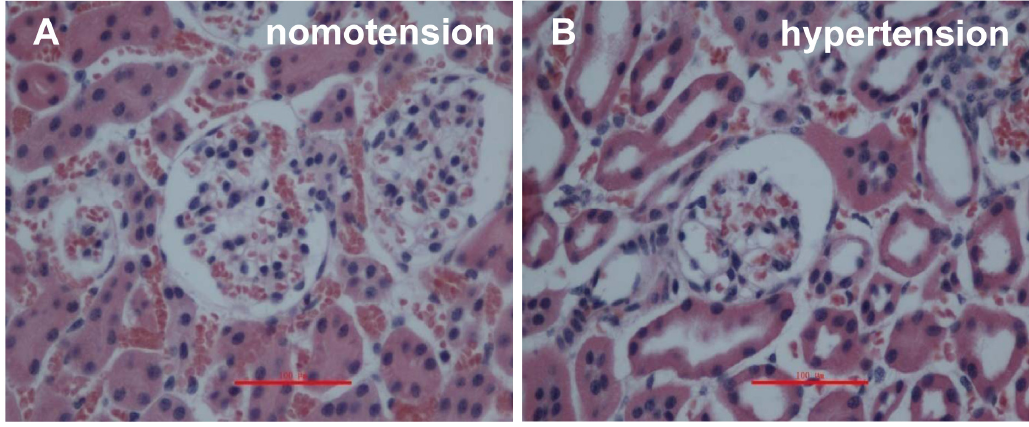
Figure 1. Light micrographs of mouse renal cortical tissues stained with